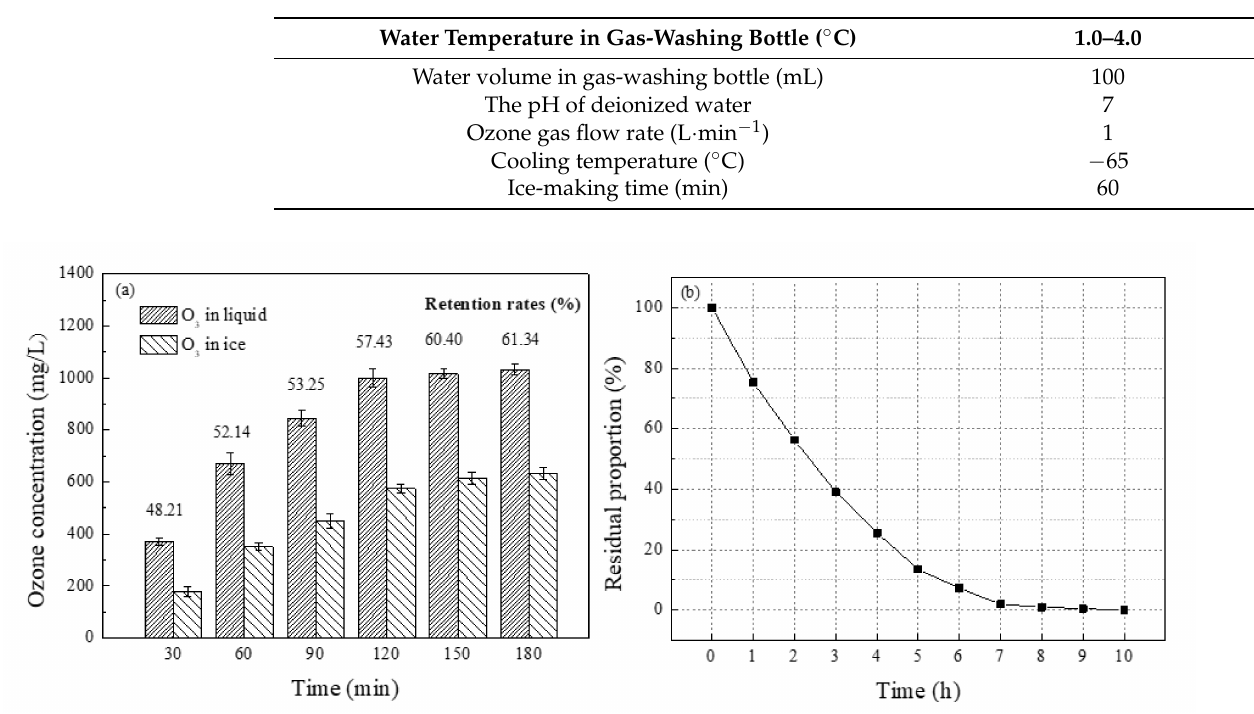
Table 2. Experimental ice-making conditions.